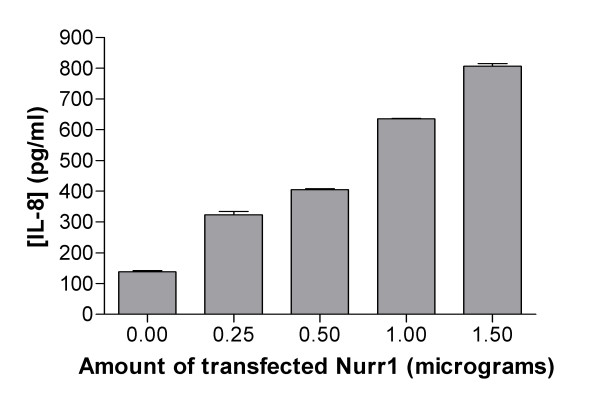
Effects on increased expression of Nurr1 on IL-8 release. 4 × 105 K4IM cells were transfected using the Amaxa Nucleofector with increasing amount of pCDNA3.1-Nurr1-WT, total amount of transfected DNA was 2 μg. Cell media was removed after 48 hour incubation and analysed for the amount of IL-8 present in the culture media using ELISA (R&D systems). Increased production of IL-8 protein secreted into the cell media was observed in a dose dependent manner with Nurr1 expression plasmid. Values expressed represent the mean concentration of IL-8 ± SEM.